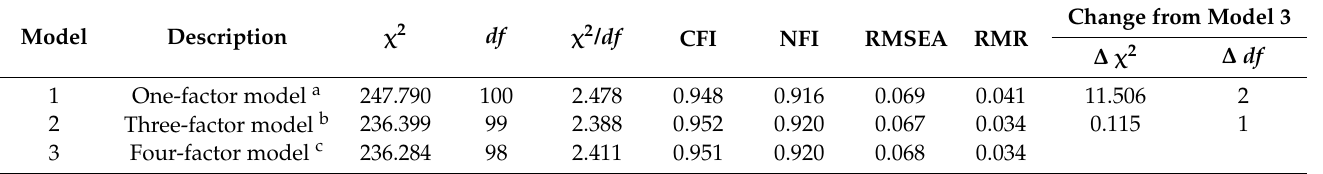
Table 1. Confirmatory factor analysis.